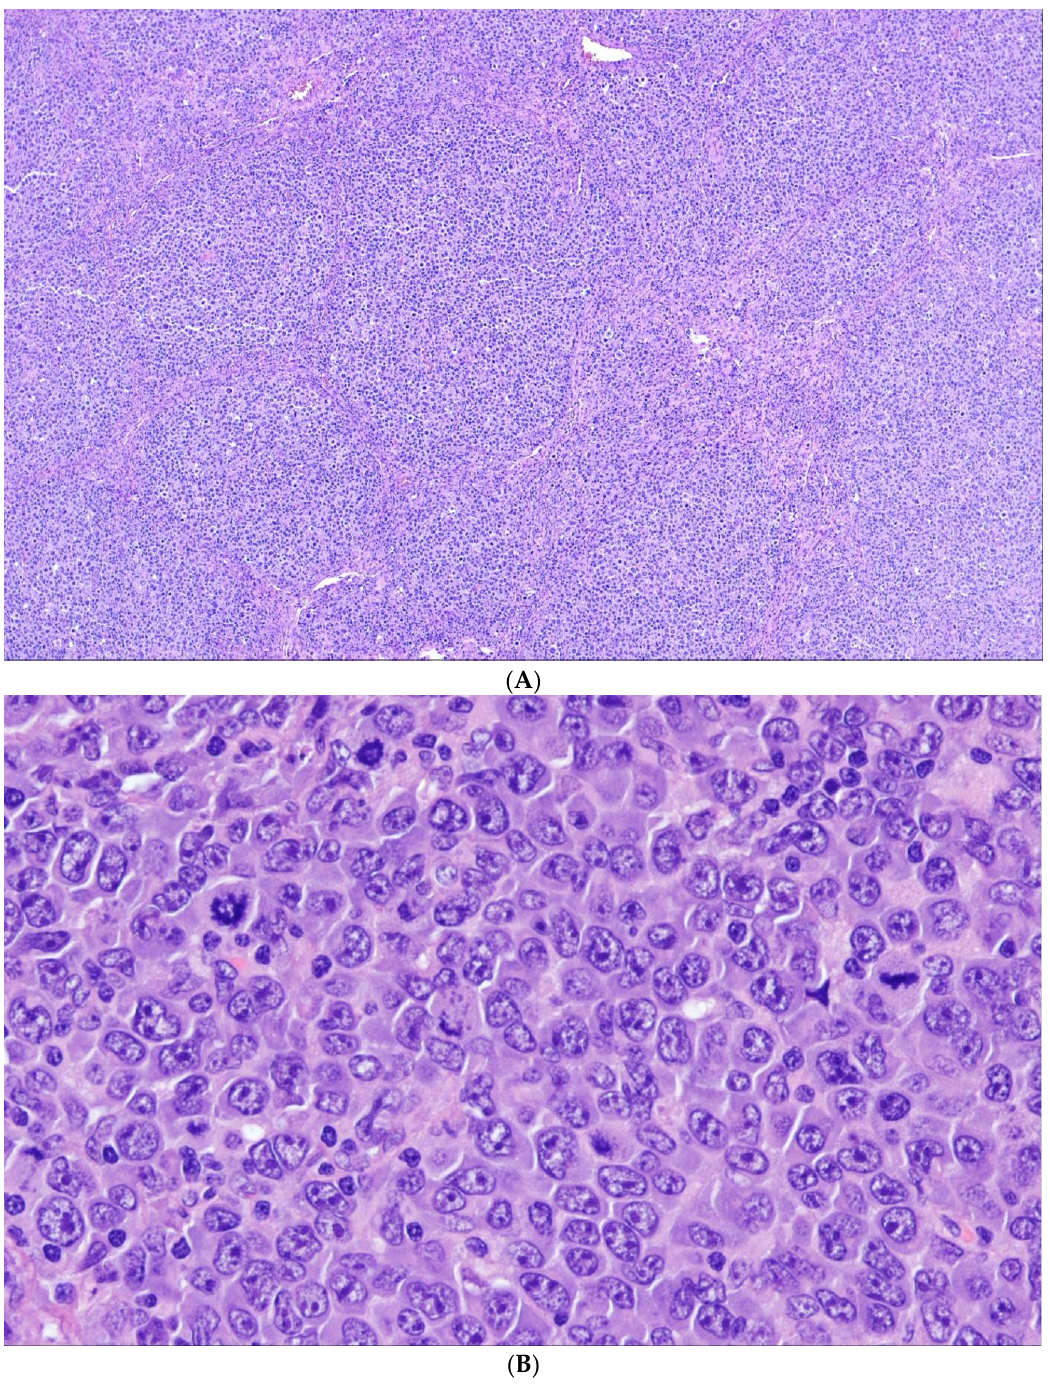
Figure 6. Follicular large B-cell lymphoma. ( A ) There is a clearly discernible follicular growth pattern (H&E × 40). ( B ) On high magnification, the neoplastic follicles are composed of large, transformed cells (centroblasts) exclusively, without an admixture of (typical) centrocytes (H&E × 400). 8. Pediatric-Type Follicular Lymphoma In WHO-HAEM5, Pediatric-type follicular lymphoma (PTFL) is defined as a localized nodal B-cell lymphoma occurring primarily in pediatric and adolescent patients [75,76]. It shows a purely follicular growth pattern of clonal GC B-cells with an elevated proliferation index and absence of BCL2, BCL6 and IRF4 rearrangements. Most cases have been diagnosed in head and neck lymph nodes [75,77]. In the great majority of cases, there is painless localized lymph node enlargement without B-symptoms. Altogether, PTFL is